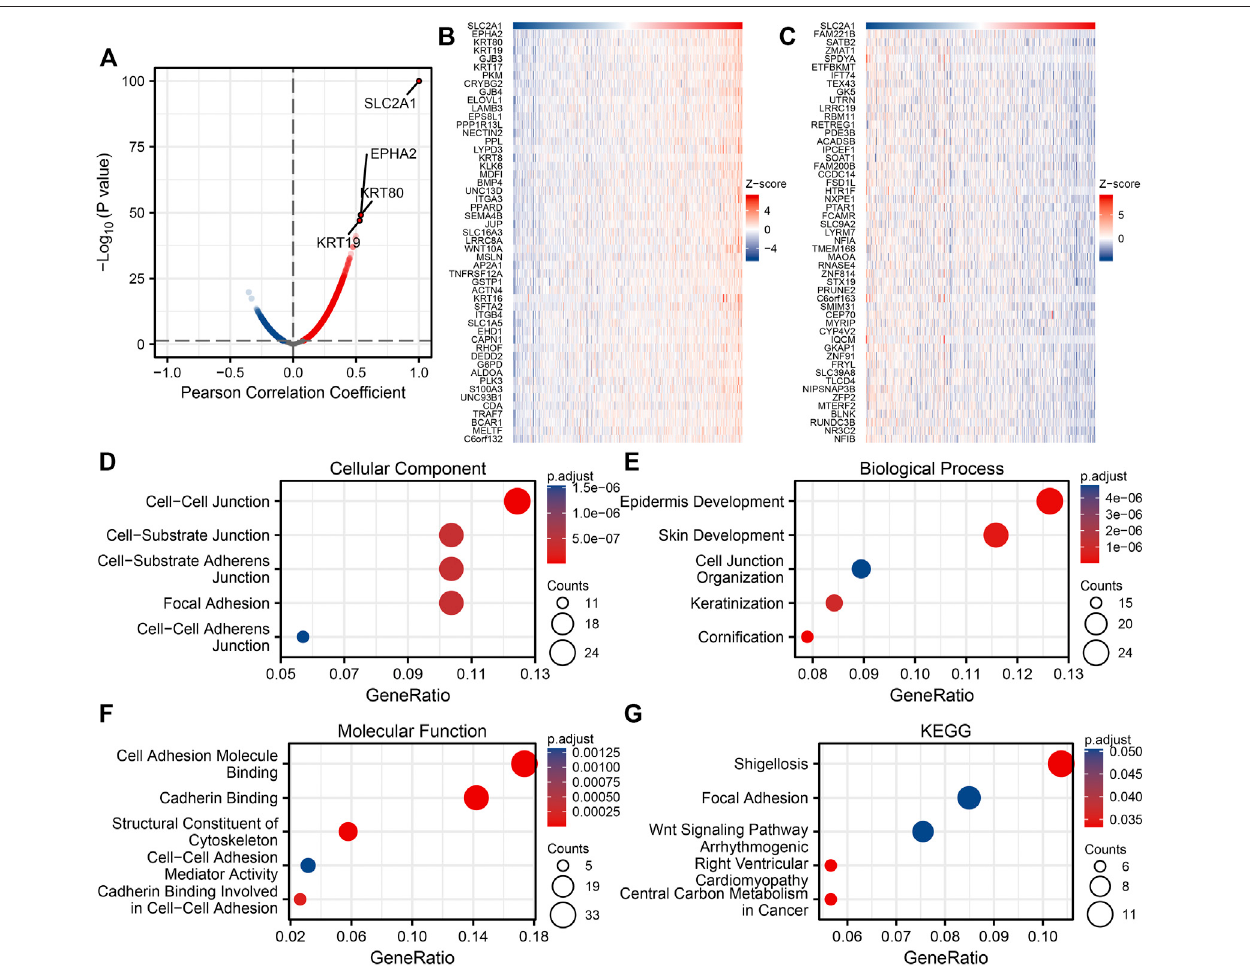
FIGURE 4 | Enrichment analysis of SLC2A1 gene co-expression network in colorectal cancer (CRC). (A) Volcano map indicated co-expression genes correlated withexpression level ofSLC2A1in TCGA CRC cohort. (B,C) Heat maps indicated thetop 50co-expression genespositivelyand negativelyassociatedwithexpression level of SLC2A1 in the TCGA CRC cohort. (D – F) Enrichment analysis of gene ontology (GO) terms for SLC2A1 co-expression genes. (G) Enrichment analysis of Kyoto Encyclopedia of Genes and Genomes (KEGG) terms for terms for SLC2A1 co-expression genes.